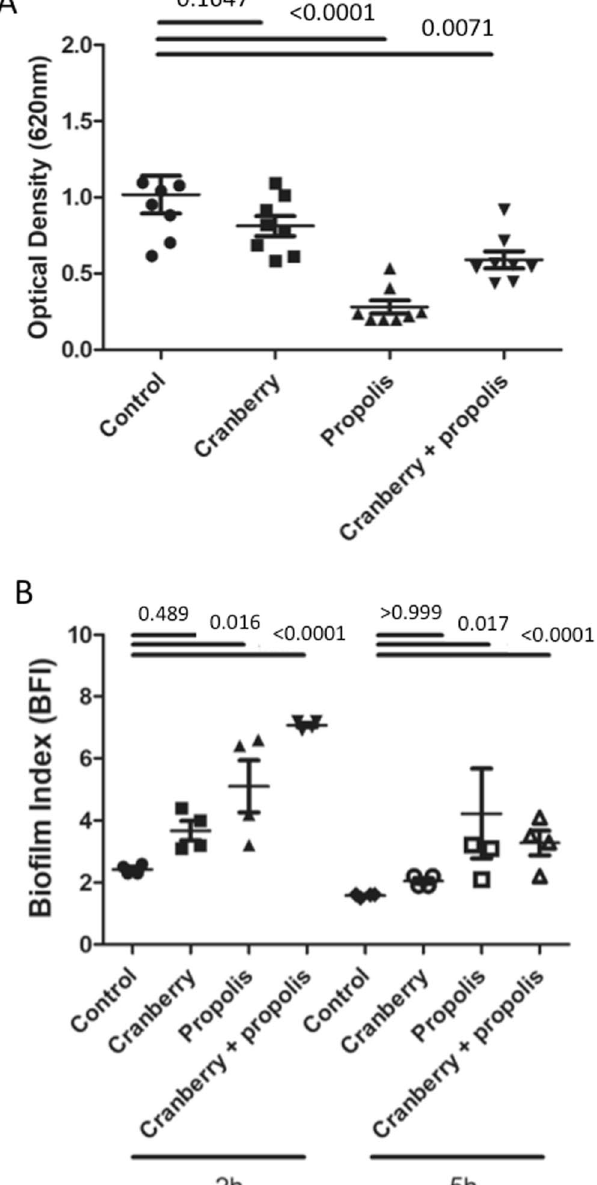
Figure 3. Effect of cranberry, propolis and both on biofilm formation. ( A ) Complete biofilm formation was determined by crystal violet experiment. The optical density (OD) is directly linked to the biofilm formation. ( B ) The kinetics of early stages of biofilm for G50 was determined by the Biofilm Ring Test at 2 h and 5 h. Biofilm Index (BFI) > 7 indicates absence of biofilm and BFI < 2 indicates a fully formed biofilm. Means and standard errors for three independent replicate are presented. Statistical differences between different growth conditions at each time were obtained by